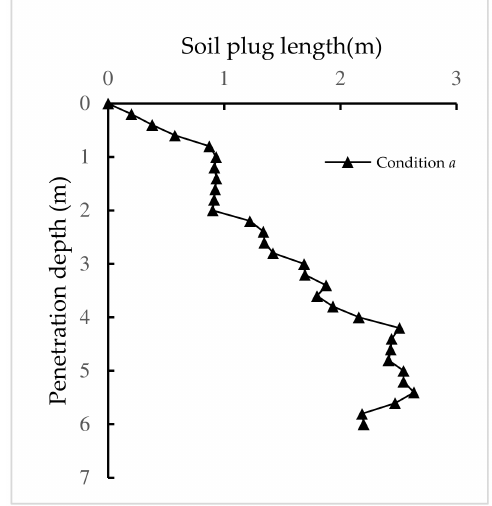
Figure 9. Soil plug length curve for condition a .